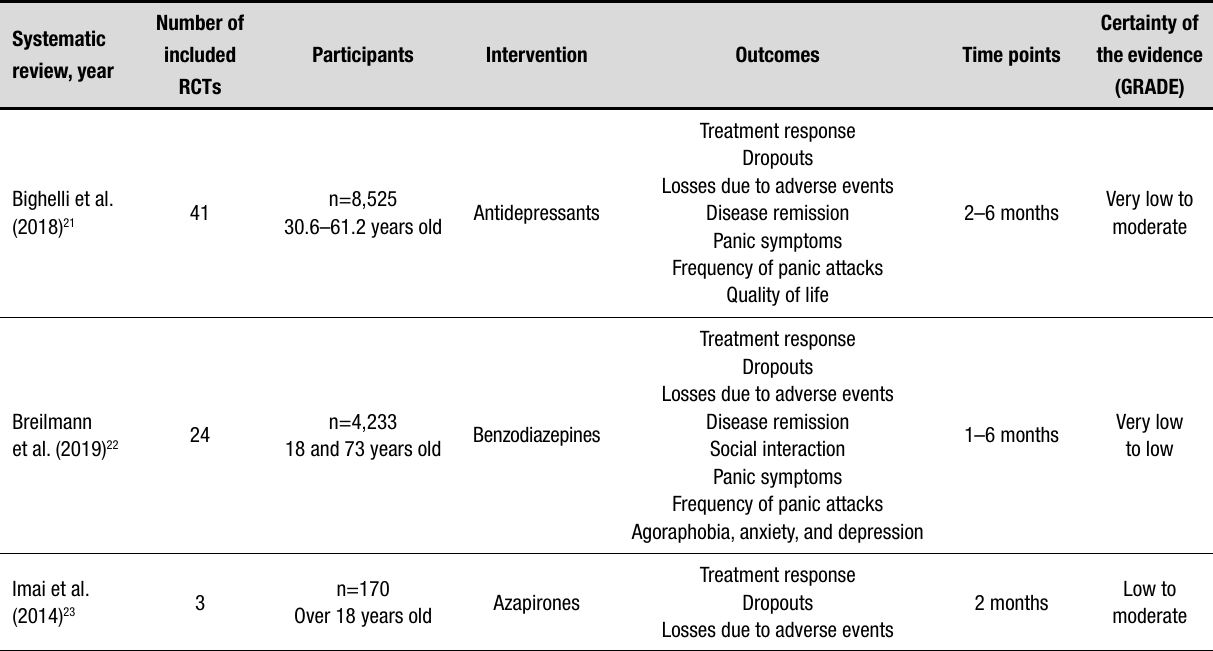
Table 1. Main characteristics of the included systematic reviews. Systematic